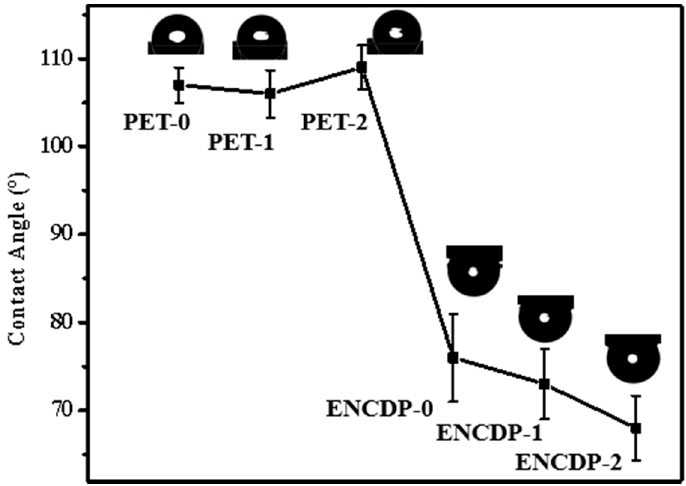
Figure 8. The contact angles of the copolyester.